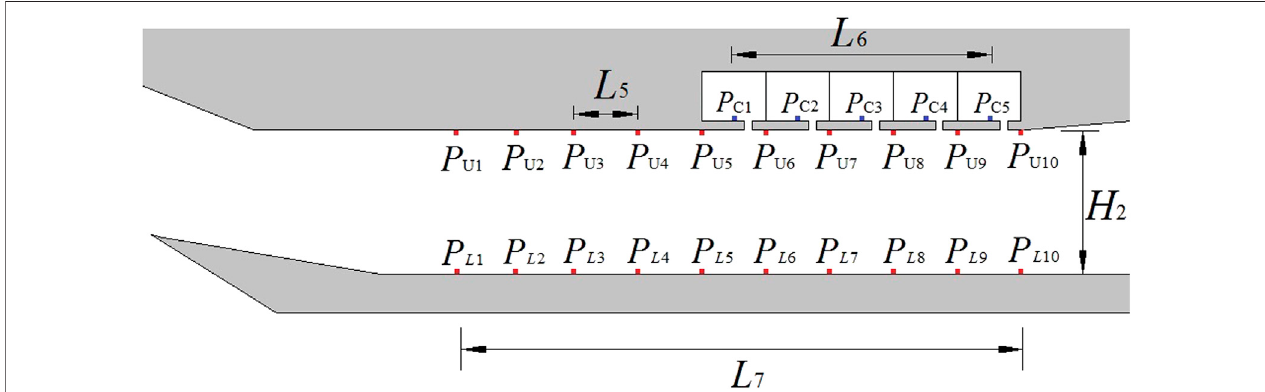
FIGURE 4 | Location of sampling